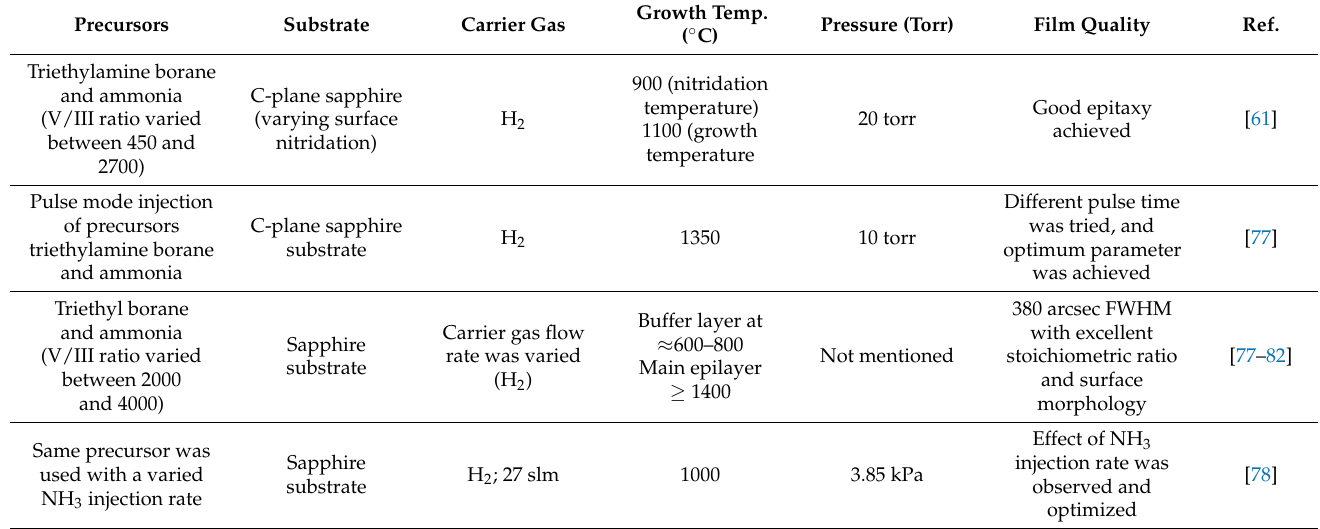
Table 4. Growth methods for h-BN.